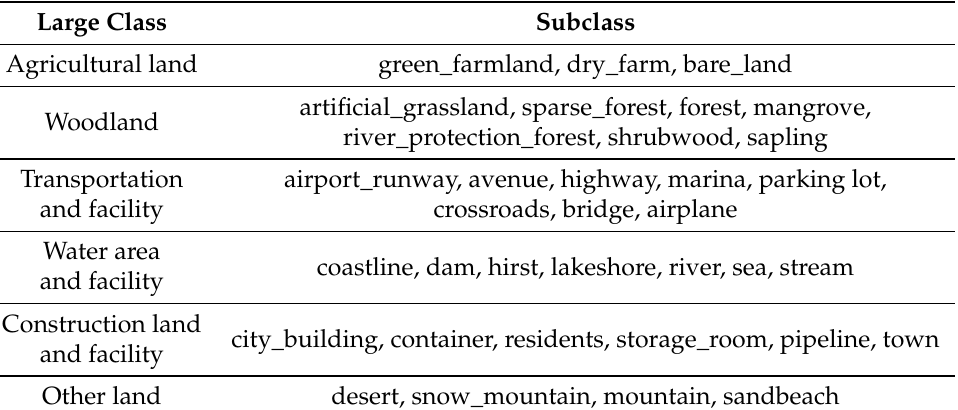
Table 3. The sub-categories corresponding to the large categories in RSI-CB.